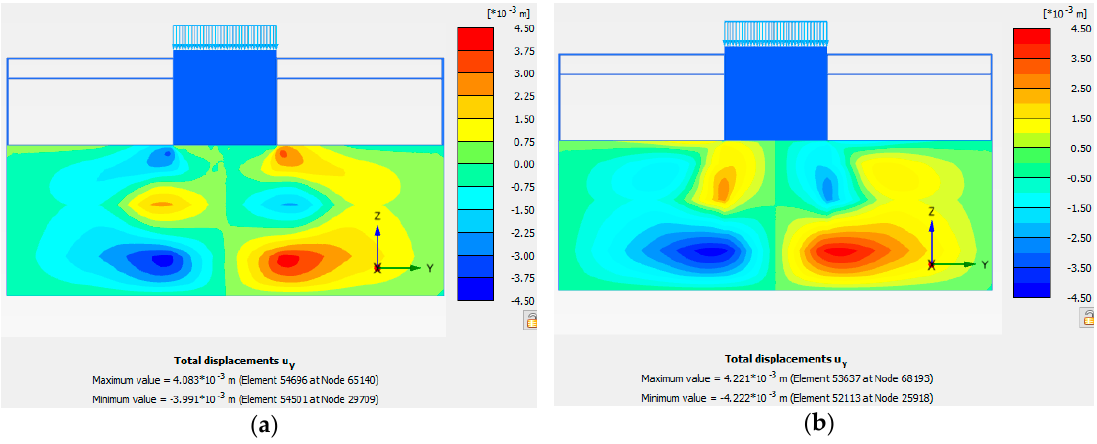
Figure 8. Comparison of horizontal deformation of the bottom cushion: ( a ) embedded pile model; ( b ) equivalent reinforcement zone model.